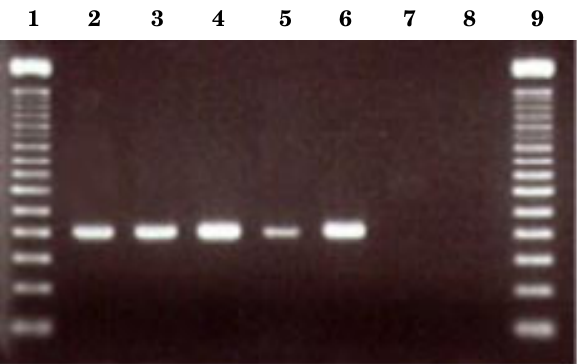
Fig. 4. Amplification products of a second-round PCR with primer-pair Dest1 and Dest4, using amplification products from ITS1F–ITS4 as a template. Lanes: 1 and 9, molecular weight markers (100 bp; GIBCO-BRL, Life Technologies); 2–5, extracts from artificially infected grapevine plants with Cy2, Cy7, Cy30 and Cy68 isolates respectively; 6, positive control (Cy1); 7 and 8, negative controls (extracts from healthy grapevines and water